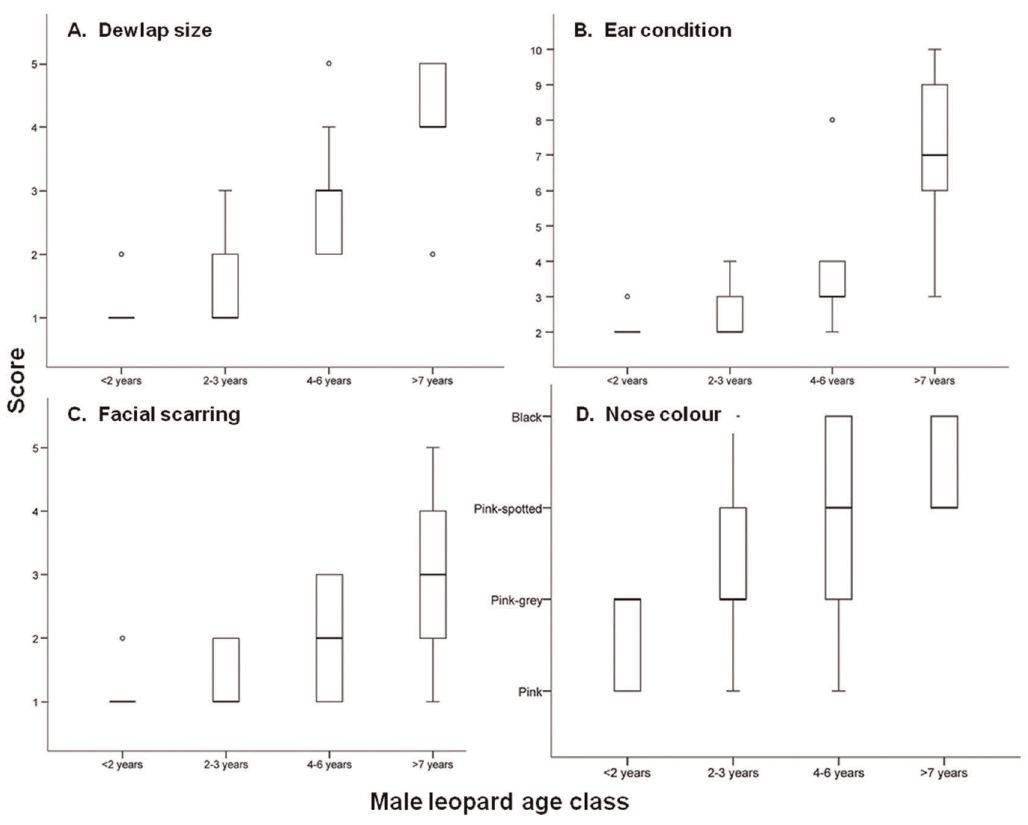
Figure 4. Relationships between four phenotypic traits and age classes of male leopards. Boxes indicate the lower, median and upper quartiles, vertical lines represent the sample minimum and maximum, and open circles correspond to outliers.